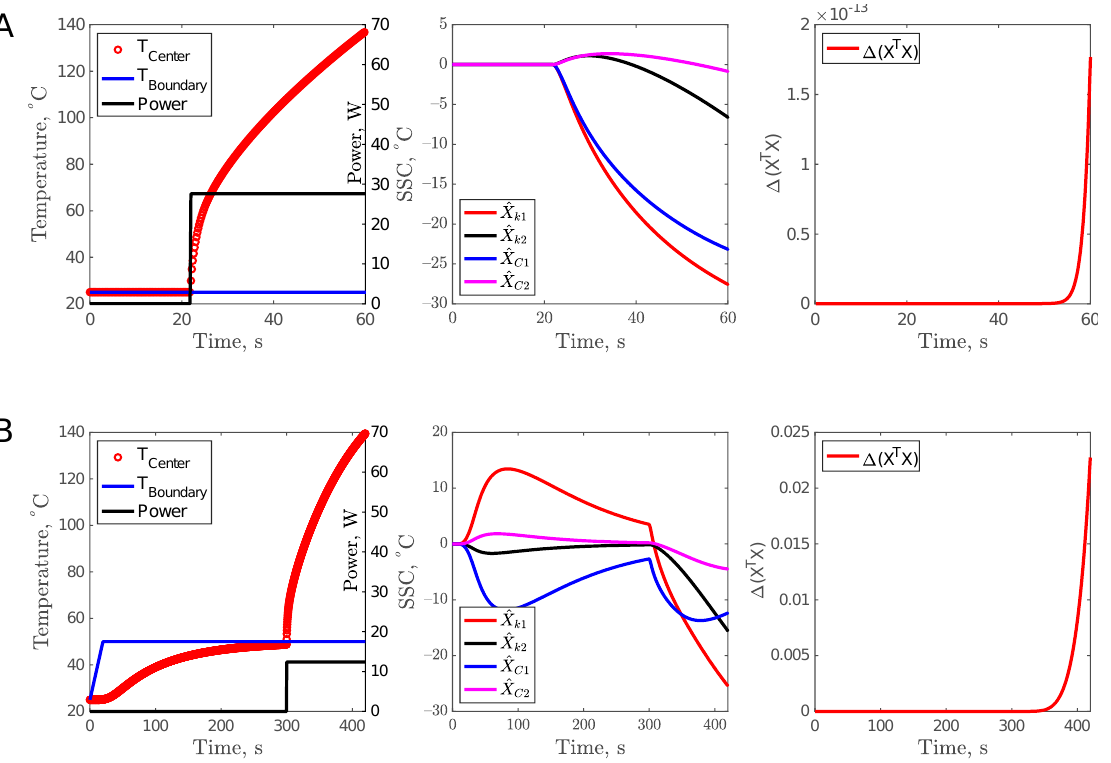
Figure 2. Non-complementary experiment ( A ), and complementary experimental design ( B ), temper- ature profile with power input ( left ), scaled sensitivity coefficients ( center ), and criteria for optimal design ( right